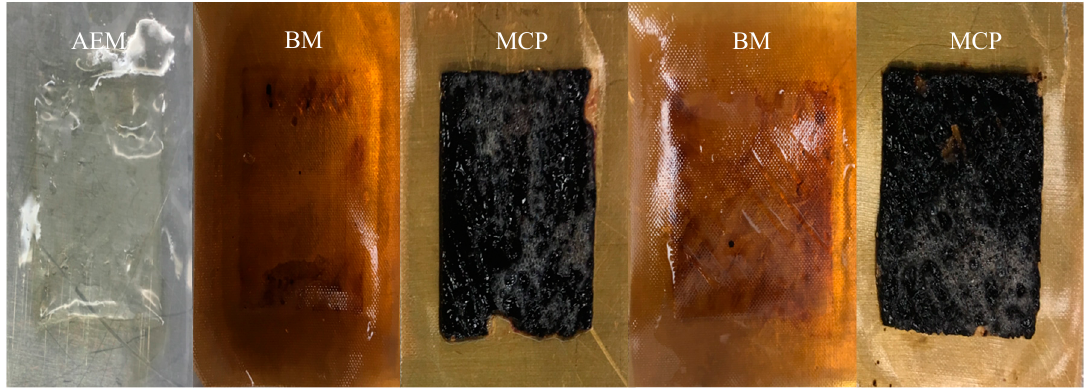
Figure 5. Hemoglobin fouling on EDBM-MCP membranes at the end of the treatment.